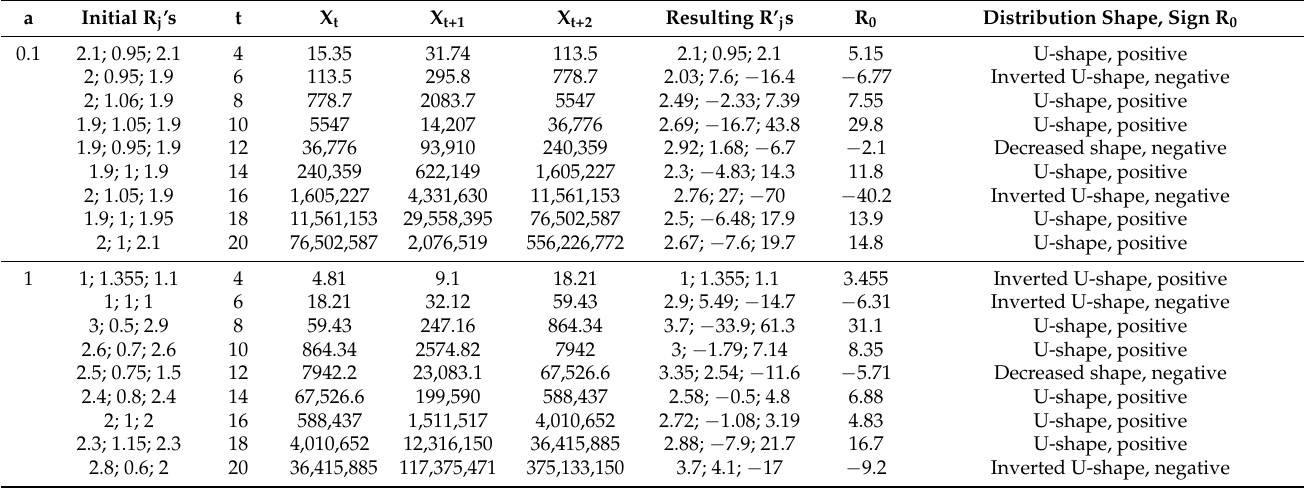
Table 1. Simulation results obtained for extreme noises a = 0.1 and a = 1, showing great variations of deconvoluted distribution of daily reproduction numbers X j ’s and a qualitative conservation of their U-shaped distribution along contagiousness